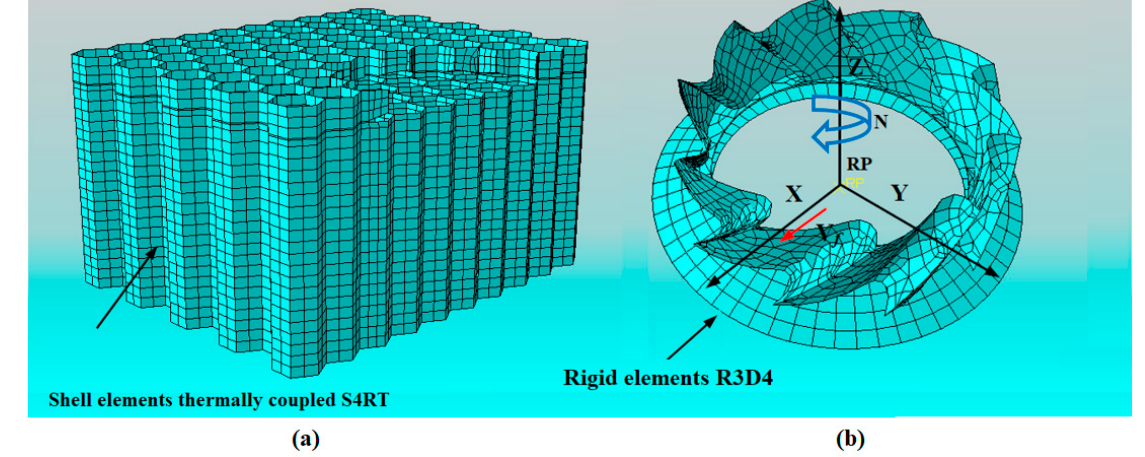
Figure 5. ( a ) Mesh used in the FE model; ( b ) cutting conditions defined at reference point RP: N is the rotation speed and V f is the feed rate.